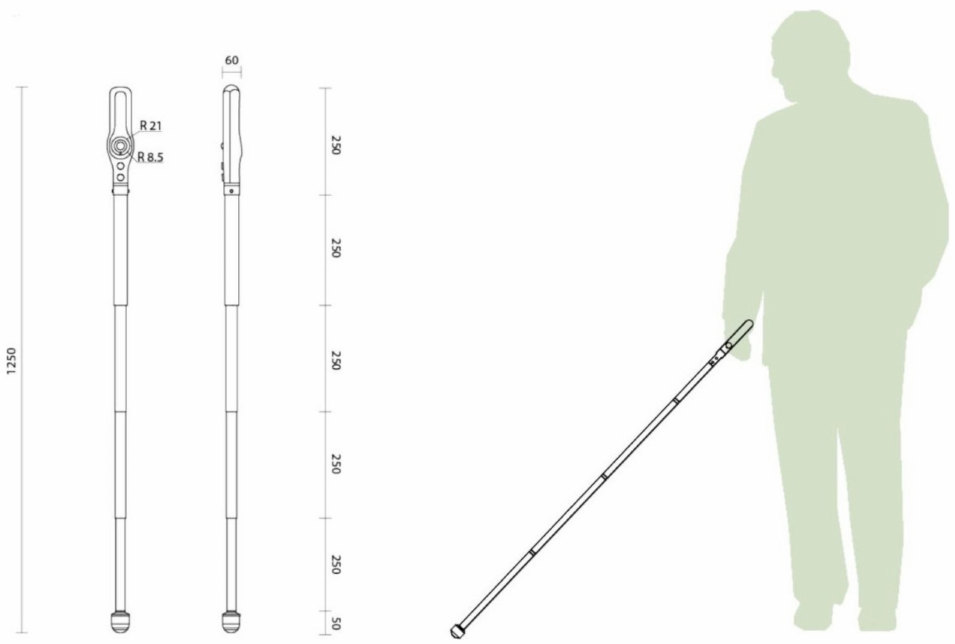
Figure 6. 2D computer-aided design (CAD) drawings.